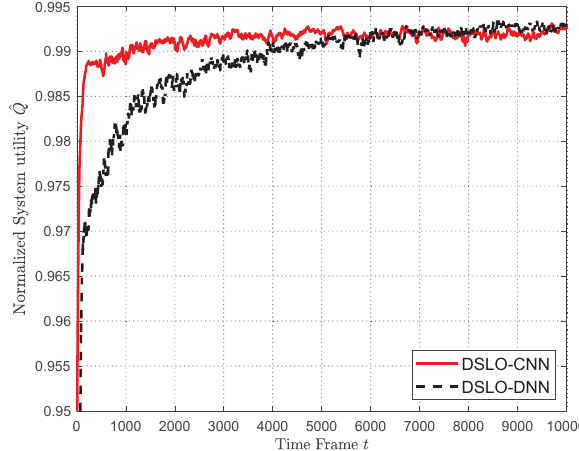
Figure 6. Convergence performance of DSLO with plenty of training samples.